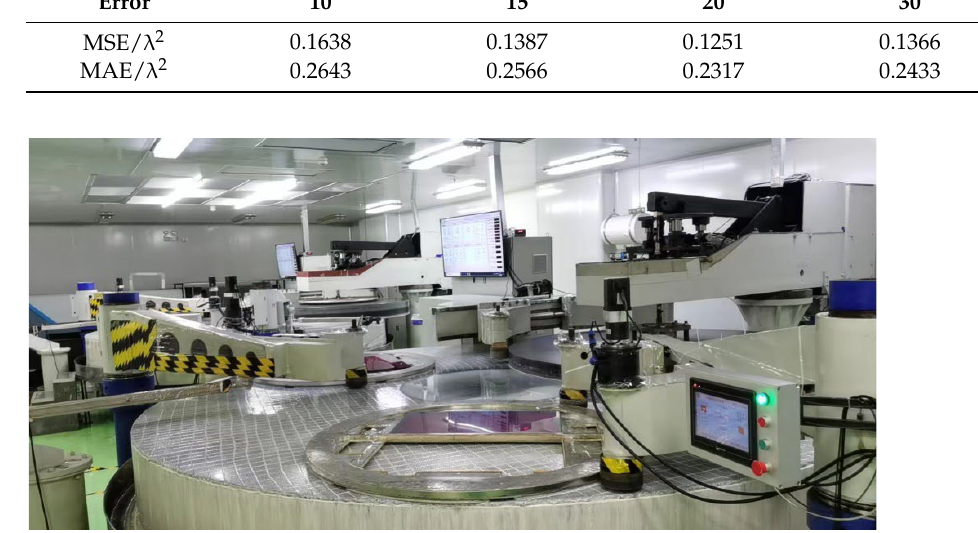
Figure 8. Continuous polishing machine 2#.